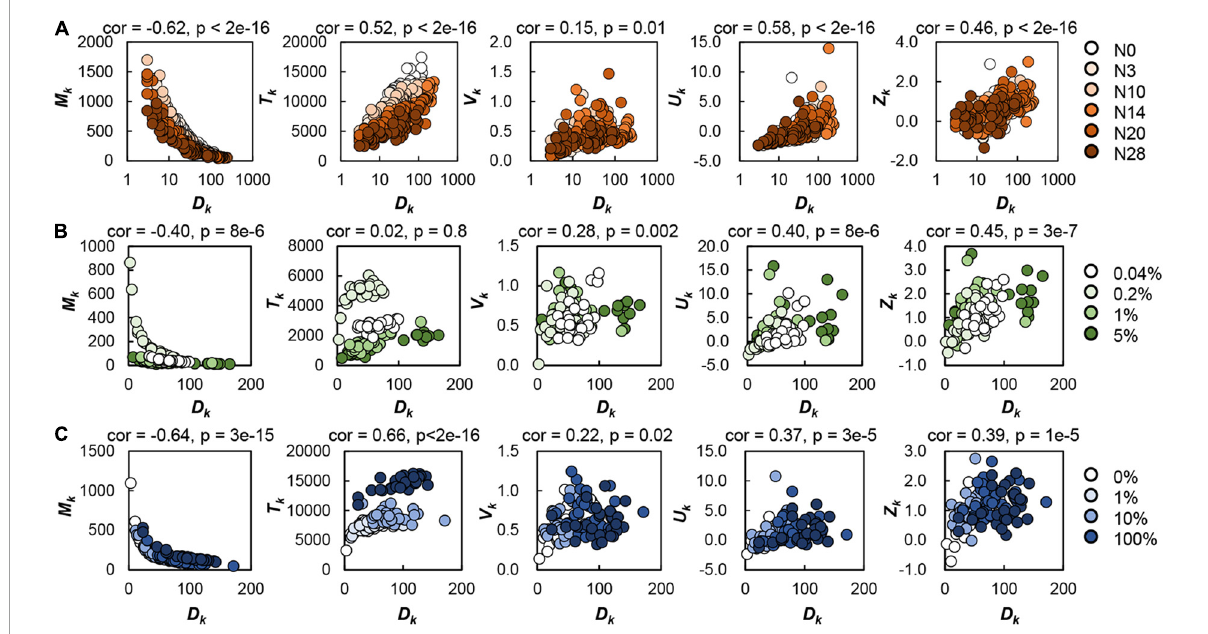
FIGURE2 Effect of spatial density on colony formation. The number of colonies grown on the single plate ( D k ) was plotted against the calculated parameters relating to the colony size and distribution on the identical plate, i.e., the mean size ( M k ), total area ( T k ) and variation ( V k ) of the colonies, and the kurtosis ( U k ) and skewness ( Z k ) of the distribution of colony size. Circles represent the plates. Orange gradation ( N = 284) indicates the genome size from the wild type to the reduced ones (A) . Green gradation ( N = 117) represents the concentration gradient of glucose in the minimal medium M63 (B) . Blue gradation ( N = 119) represents the ratio gradient of LB in the mixed medium M63LB (C) . Pearson’s correlation coefficients and the p -values are indicated.